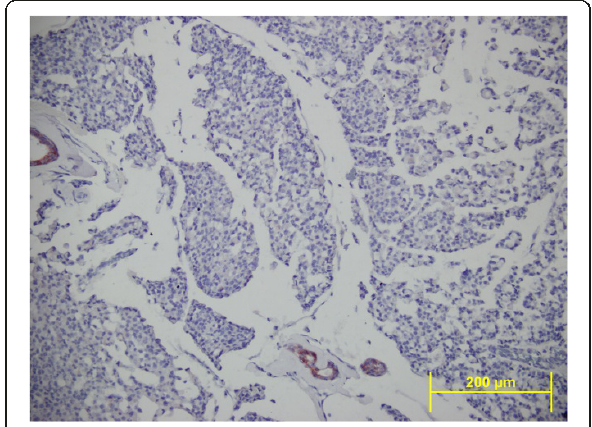
Figure 6 Immunohistochemical stain showed absence of membranous E-cadherin staining. The duct which is a positive internal control seen in the image (E-cadherin